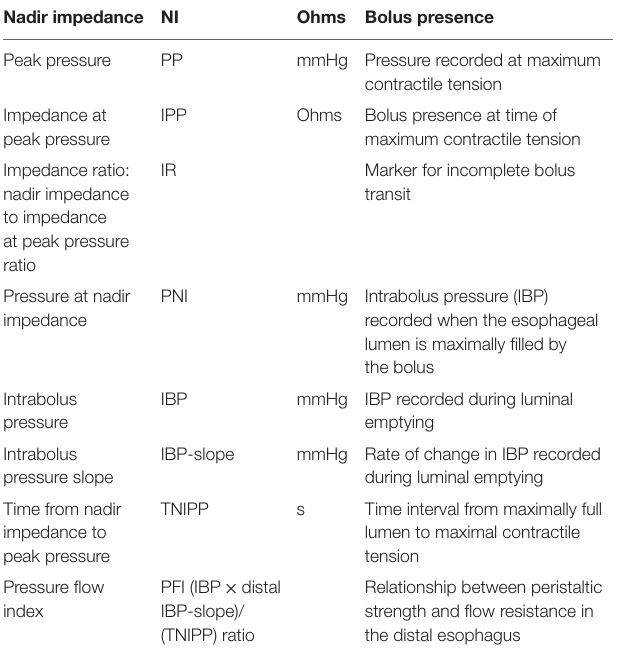
TABle 1 | Pressure flow metrics.